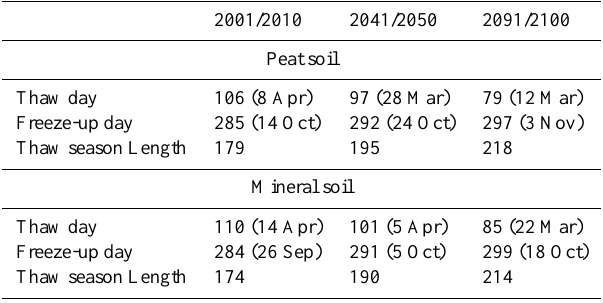
Fig. 4. Time series of the mean simulated start and end of the freez- ing period at the surface for grid cells with peat soils and one stan- dard deviation around the